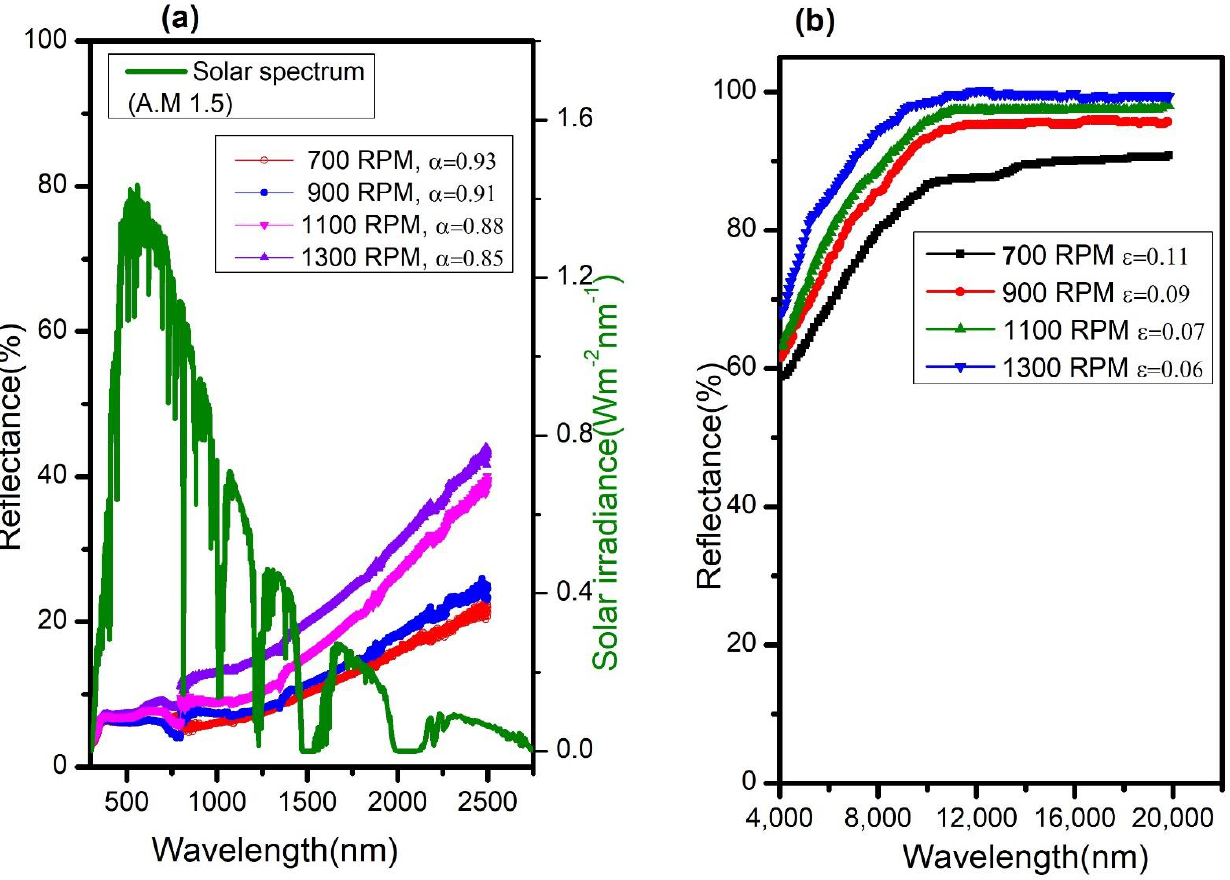
Figure 9. ( a ) Reflectance spectra of green synthesized NiO thin films prepared at different RS in the ( a ) UV–Vis–NIR region, ( b ) IR